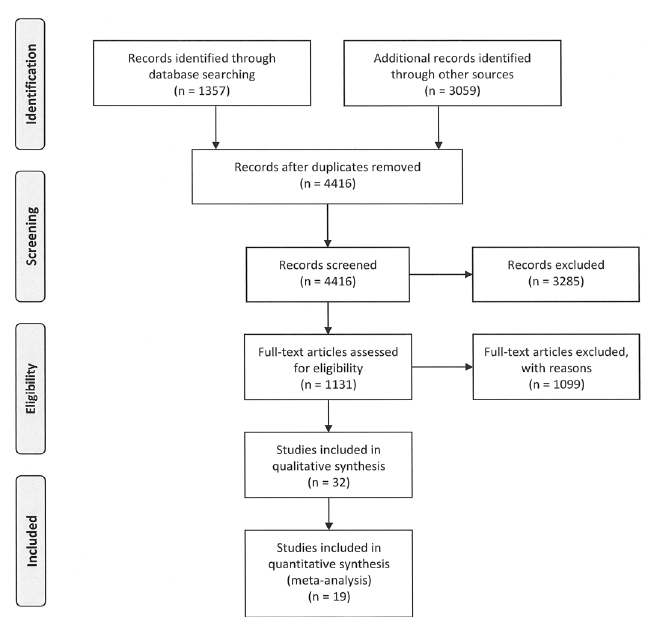
Figure 1. PRISMA diagram of articles identified during the article search and abstraction